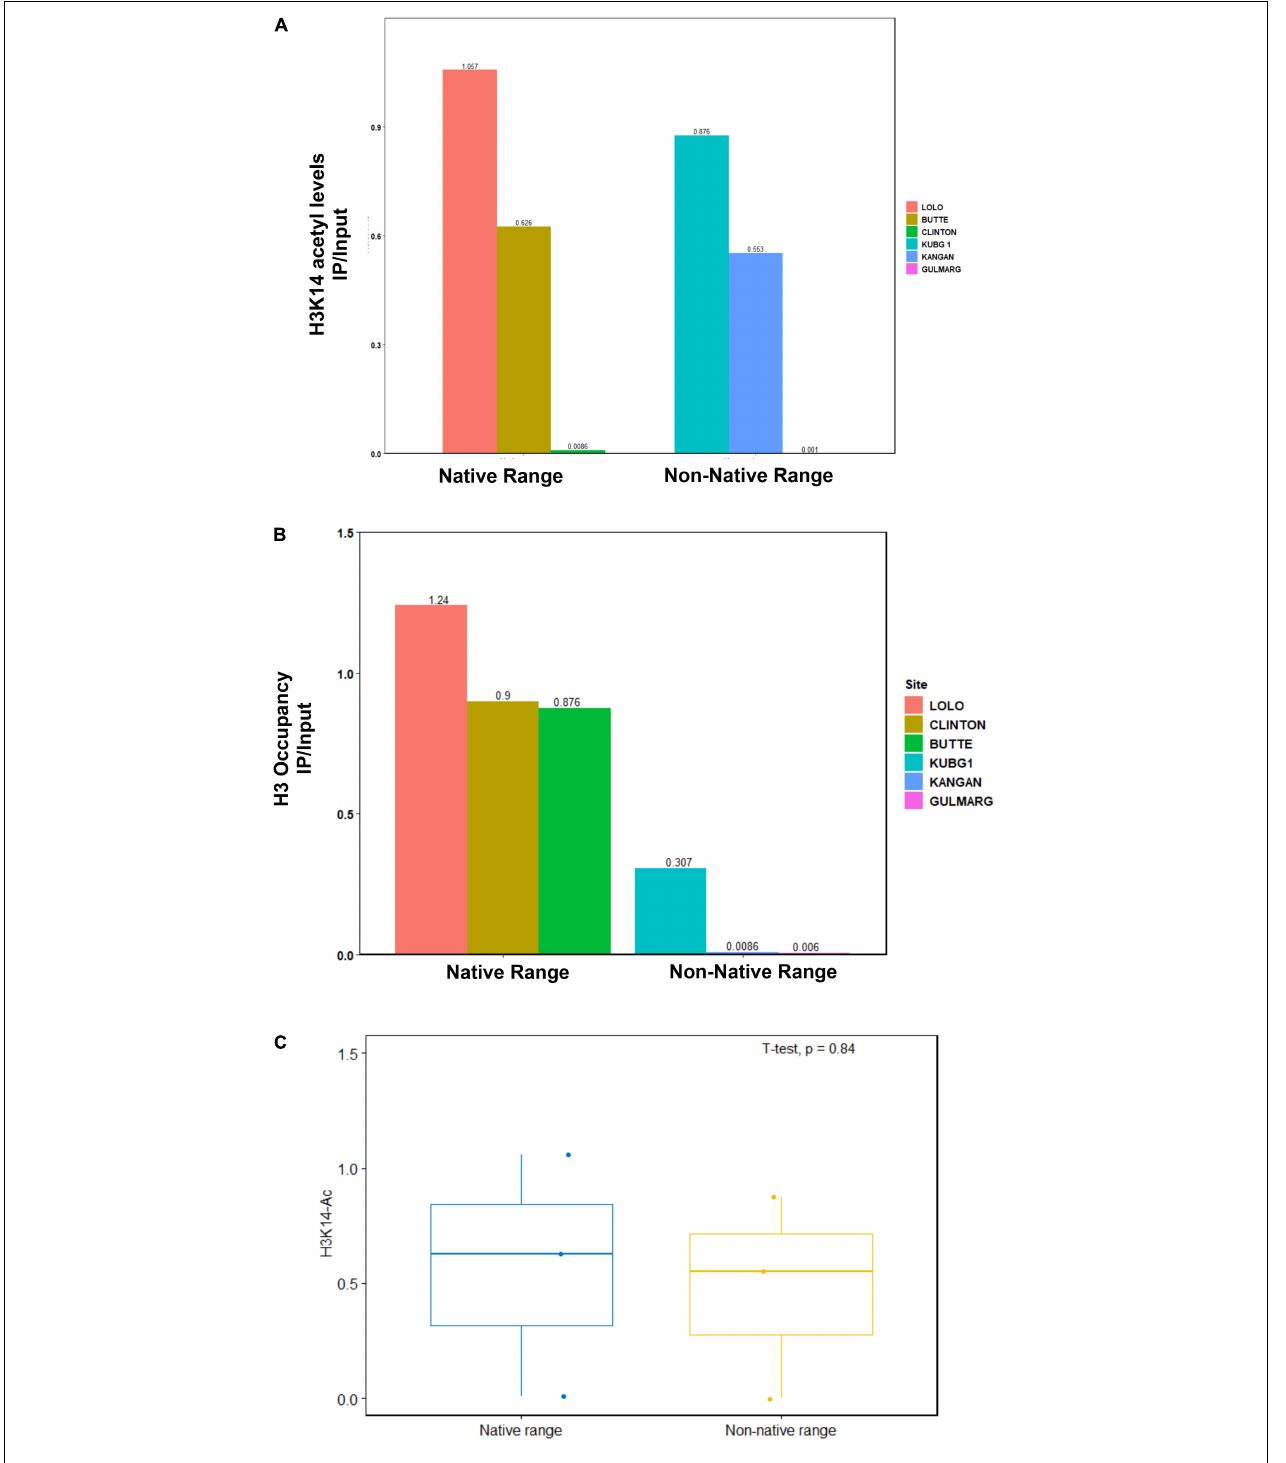
FIGURE 3 | H3 and H3K14 acetyl occupancy in the native (North America) and non-native (Kashmir Himalaya) range plants. The plant material was collected at different geographical locations as mentioned in “Materials and Methods” section. The DNA-protein interaction was cross-linked with a suitable cross-linking agent. Subsequently, the DNA was isolated, sonicated, and then subjected to immunoprecipitation using specific antibodies. (A) The bar graphs represent the IP/Input ratio of H3K14ac occupancy at ABC transporter genes in the native and non-native range plants. (B) The bar graphs represent the IP/Input ratio of H3 occupancy at ABC transporter genes in the native and non-native range plants. (C) H3K14 acetyl occupancy at ABC transporter gene in the native and non-native range obtained using R software, n = 3.